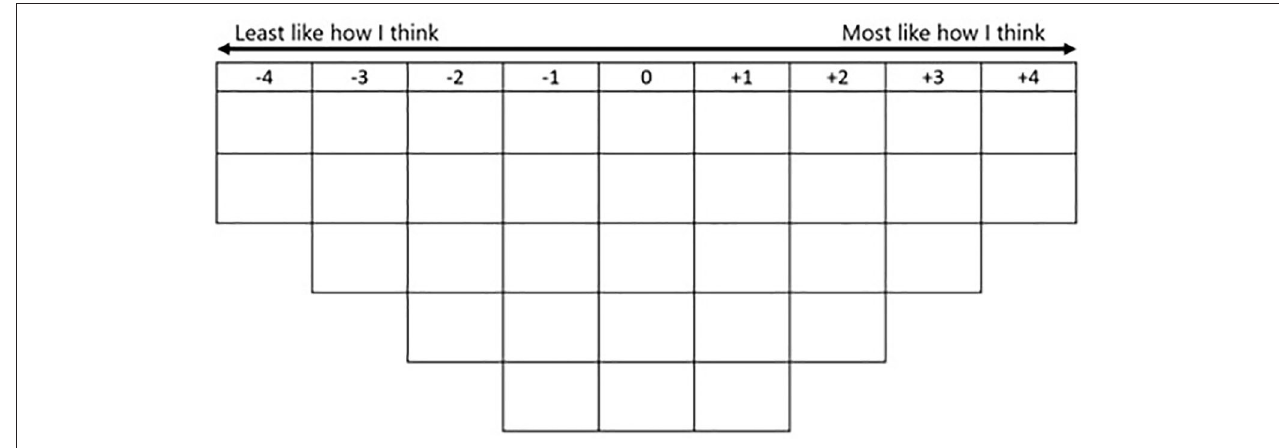
FIGURE 1 | The Q Method grid, as used in this